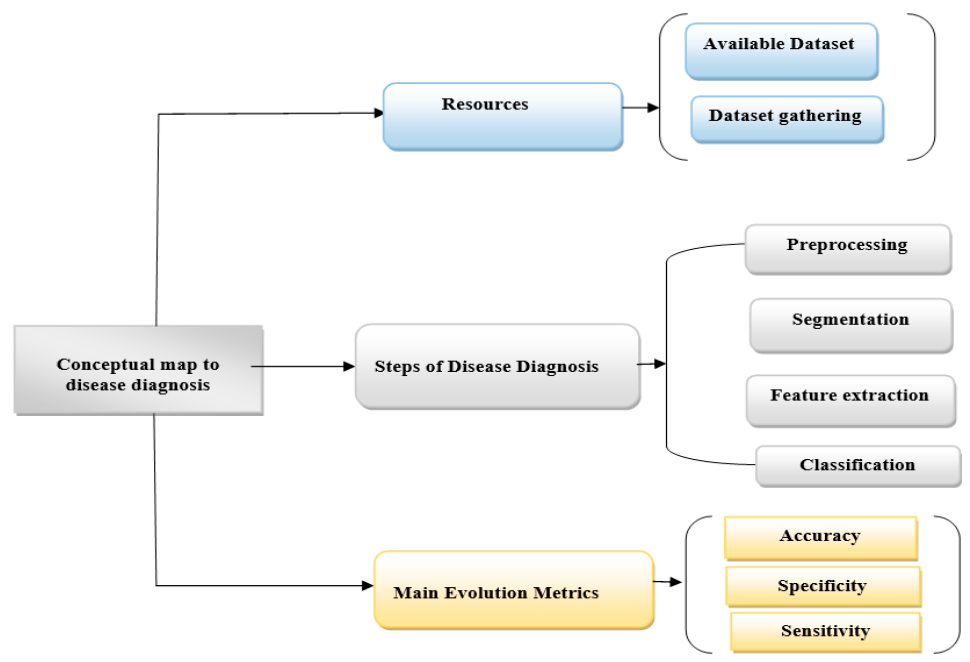
Figure 3. Conceptual map of disease diagnosis system.